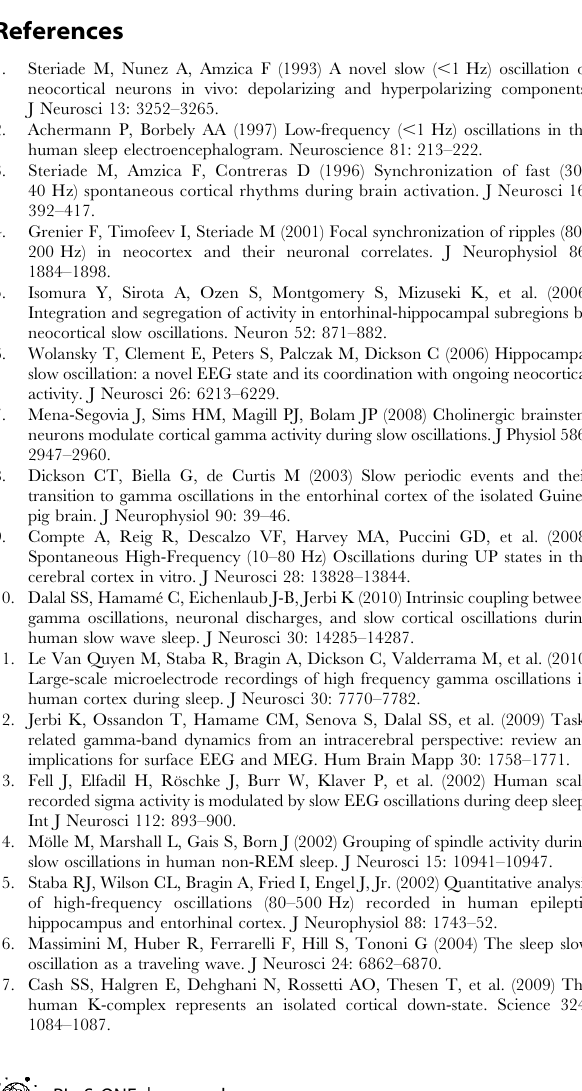
Table S1 Depth electrodes implantation data. Contacts in the epileptic ictal zone corresponds here to contacts associated with seizure onsets. Contacts in the epileptic interictal zone corresponds here to contacts associated with epileptic spikes during interictal periods. Contacts between two adjacent regions were considered as half in each one. (DOC) Table S2 Regional distribution of intracranial contacts related to IN-phase pattern. Table S3 Regional distribution of intracranial contacts related to ANTI-phase